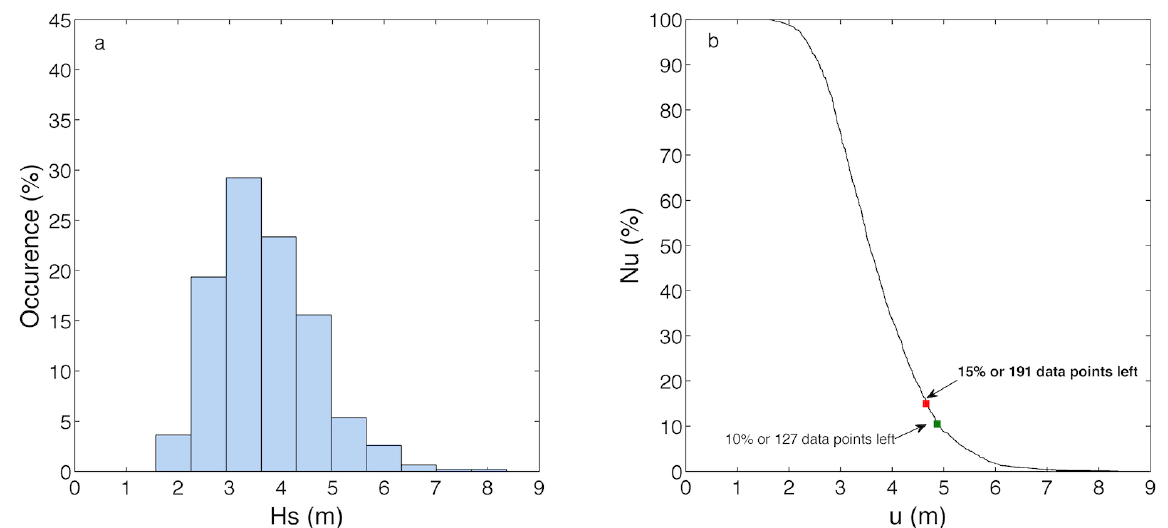
Figure 6. (a) Histogram of occurrence (%) versus Hs. (b) Nu versus u, red and green point correspond 15% and 10% of the data, respectively.